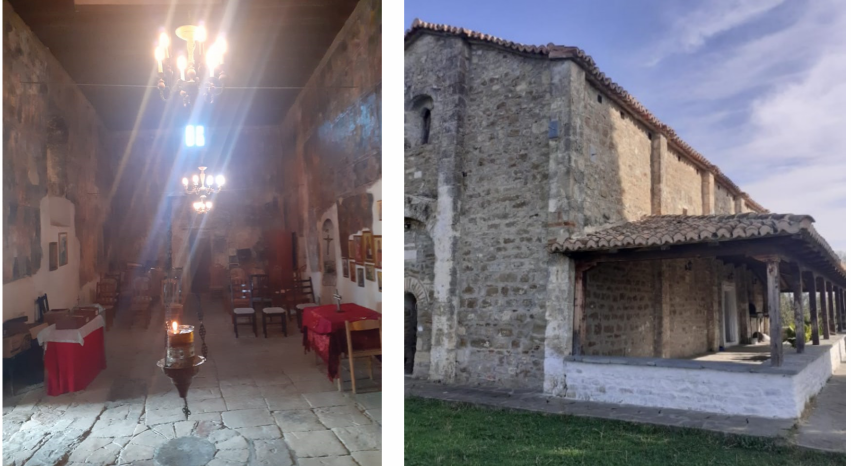
Figure 5. Internal ( left ) and external ( right ) view of St Paraskevi’s church of Cete.